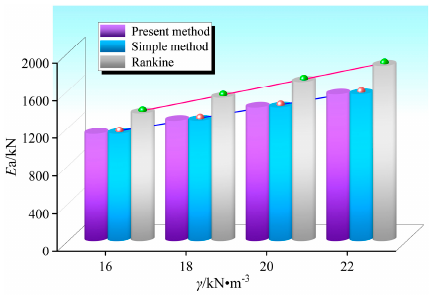
Figure 23. The influence of the unit weight.